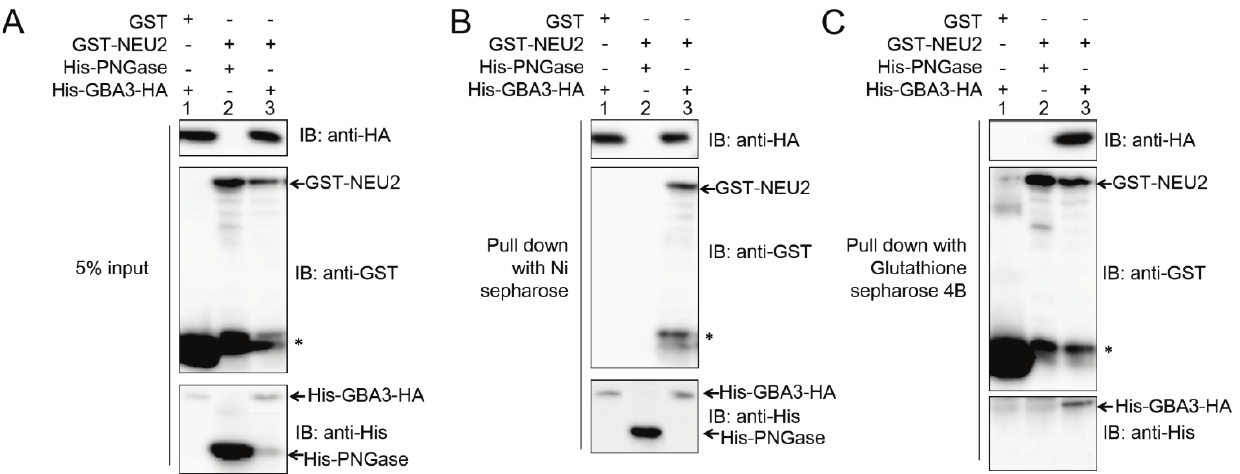
Figure 2. Co-precipitation assay of recombinant His-GBA3-HA and GST-NEU2. 500 (cid:4)L of purified recombinant His-GBA3-HA (1.5 mg/mL) and recombinant GST-NEU2 (1.5 mg/mL) were incubated together overnight at 4 °C. As the negative control, His-GBA3-HA was mixed with GST alone and GST-NEU2 was mixed with His-PNGase, respectively. Five percent of input was shown by western blotting ( A ). The mixtures were then pulled down with 20 (cid:4)L Ni-Sepharose™ (GE Healthcare Japan, Tokyo, Japan) 6 Fast Flow ( B ) or Glutathione-Sepharose™ (GE Healthcare Japan) 4B ( C ), and proteins that were bound to the resin were boiled in sample buffer, subjected to SDS-PAGE and western blotting. An anti-HA antibody was used to detect His-GBA3-HA; an anti-GST antibody was used to detect GST and GST-NEU2; an anti-His antibody was used to detect His-GBA3-HA and His-PNGase. Representative data from three independent experiments were shown. Asterisk (*) indicates the proteolytic fragments of GST-NEU2 which co-purify with the intact